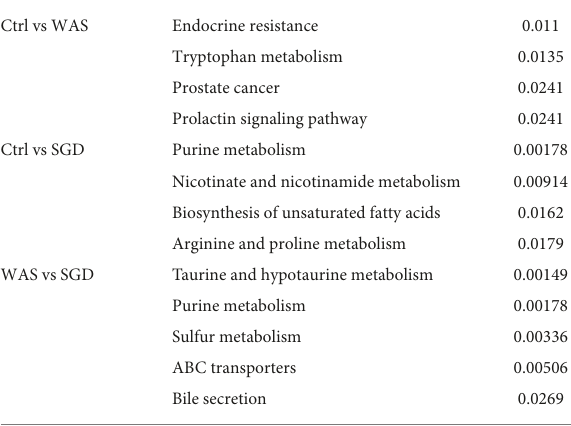
TABLE 1 KEGG pathway with significant differences between different groups are as follows ( P < 0.05). Groups (A vs B) KEGG metabolic pathways’ name P value